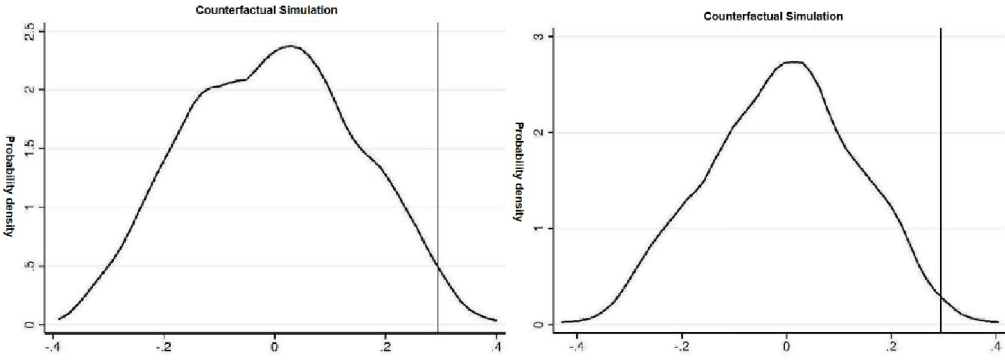
Fig 2. Placebo test for randomly selected groups (500